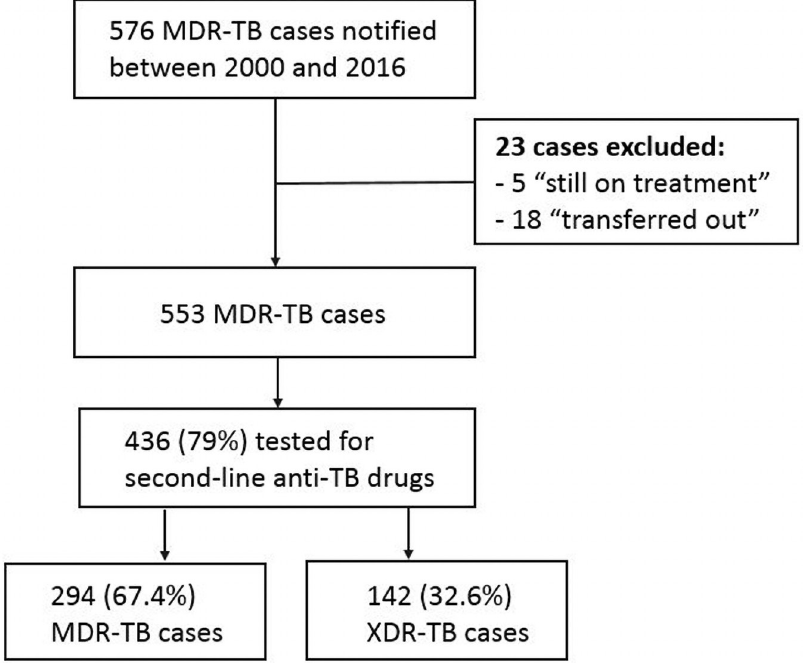
Fig 1. Flowchart of the cases included in the analysis, considering MDR-TB cases reported between 2000 and 2016 in Portugal. MDR-TB = multidrug-resistant tuberculosis; XDR-TB = extensively drug-resistant tuberculosis.